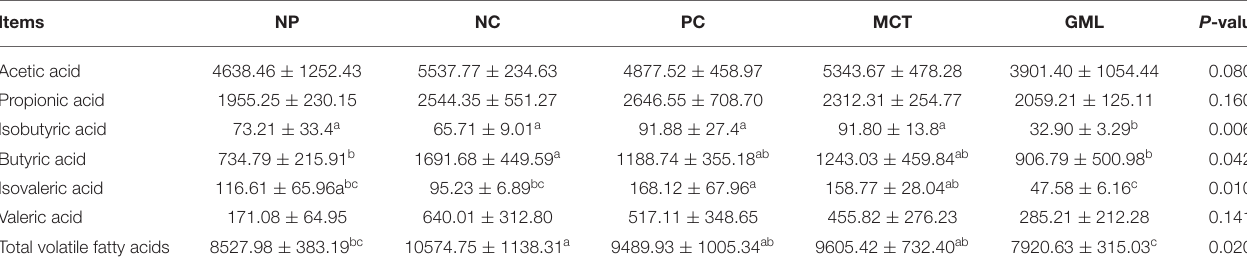
TABLE 4 | Effect of medium-chain fatty acid glycerides supplementation on volatile fatty acids contents in the colon chyme of piglets ( µ g/g). Items NP